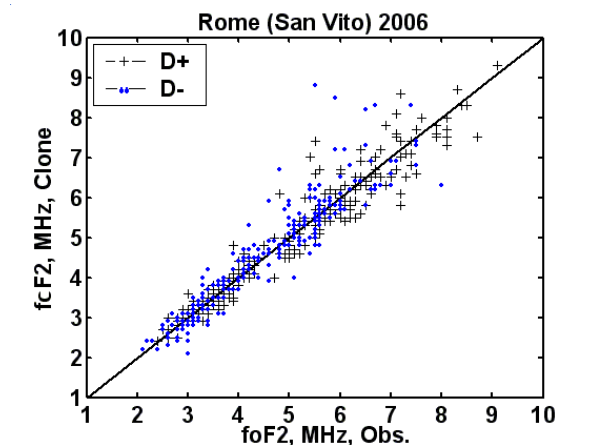
Fig. 1. Bias of the median for 27 preceding days and the 27-day median centered on a given day calculated from foF2 critical fre- quency at Chilton (winter – January, equinox – March, summer – May 2006).